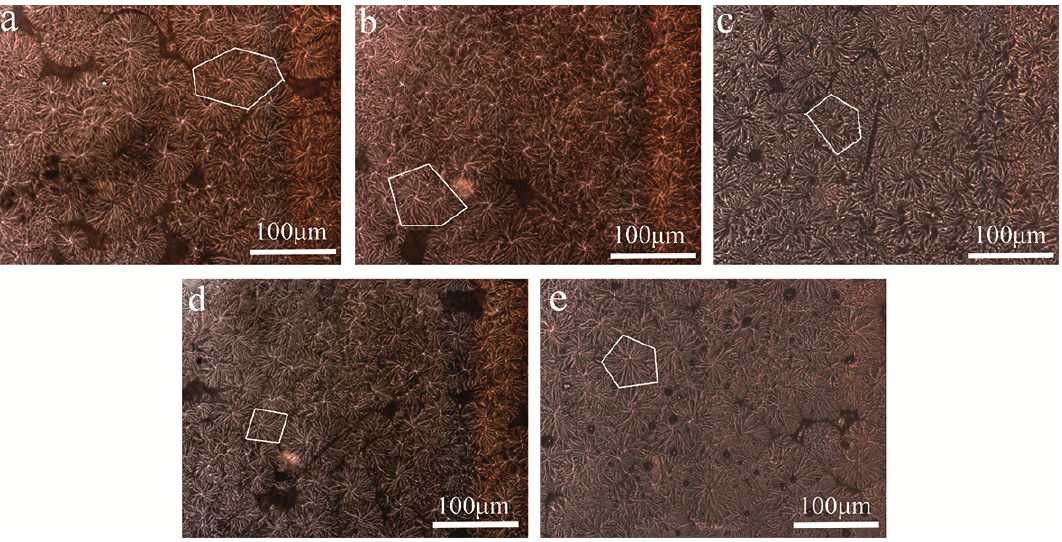
Figure 11. PLM photographs of POM/Ag nanocomposites: ( a ) POM, ( b ) POM ‐ 1, ( c ) POM ‐ 2, ( d ) POM ‐ 3 and ( e ) POM ‐ 4. (The white parts indicate spherulites).